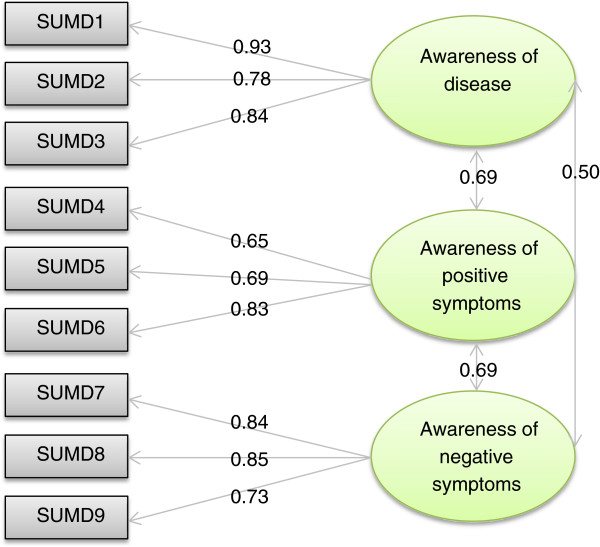
LISREL confirmatory structural model (model 1, ‘not applicable’ = ‘0’). SUMD1: Awareness of a mental disorder, SUMD2: Awareness of the consequences of a mental disorder, SUMD3: Awareness of the effects of drugs, SUMD4: Awareness of a hallucinatory experience, SUMD5: Awareness of delusional ideas, SUMD6: Awareness of disorganised thoughts, SUMD7: Awareness of blunted affect, SUMD8: Awareness of anhedonia, SUMD9: Awareness of lack of sociability.